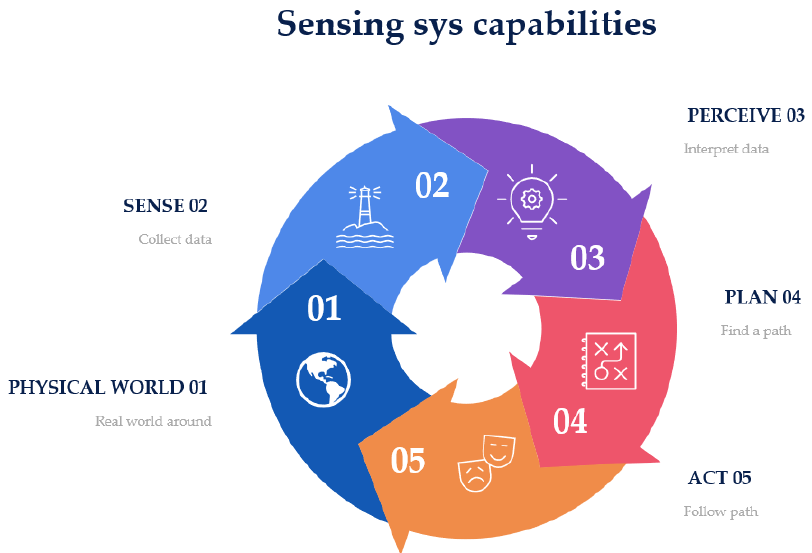
Figure 10. Key capabilities of the handheld device-based indoor localization with zero infrastructure (HDIZI) approach.